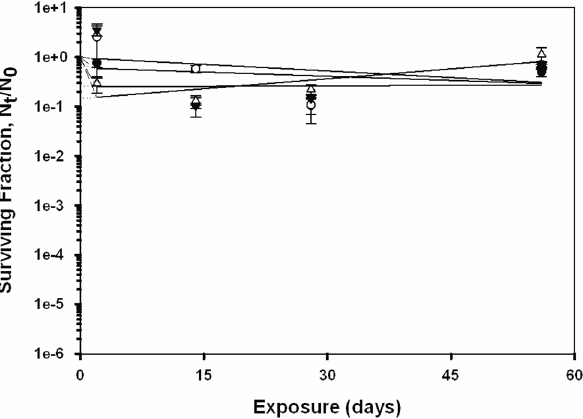
Fig 5. Inactivation curves of B . subtilis and B . anthracis spores on topsoil. Circles represent B . subtilis , triangles represent B . anthracis , shaded symbols represent coupons exposed to UV, and non-shaded symbols represent the coupons that were not exposed to UV. The data points and error bars are the averages and standard deviations of results from five replicate coupons. The surviving fraction of spores after each experiment was calculated by N t /N 0 , where the viable spore titer at any given time point ( N t ) was divided by the initial spore titer ( N 0 ). Dashed and solid lines represent the initial (first phase) and final (second phase) slopes of the curve, respectively.